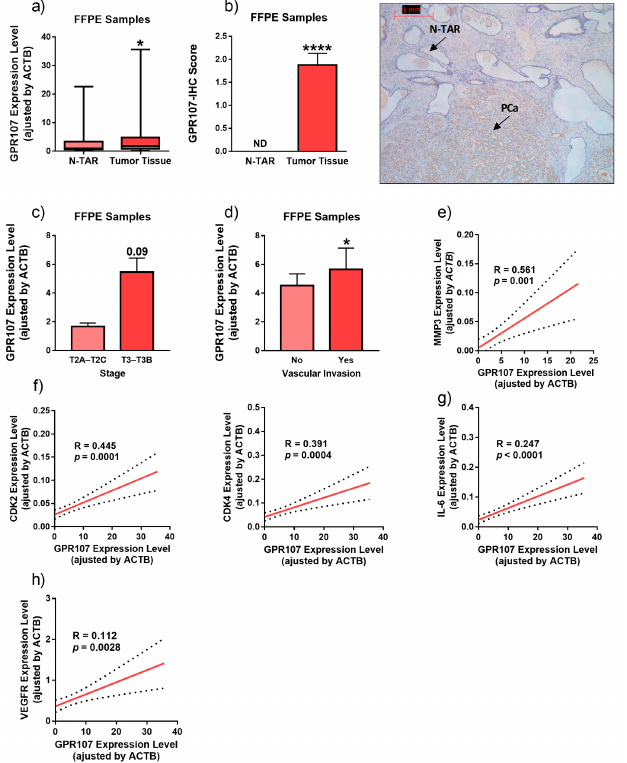
Figure 1. Expression levels of G protein-coupled receptor 107 (GPR107) in human prostate cancer samples. ( a ) Comparison of GPR107 expression levels between formalin-fixed paraffin embedded (FFPE) samples from Prostate Cancer (PCa) tissues and non-tumor adjacent regions (N-TAR) ( n = 84). ( b ) Comparation of GPR107 protein levels by Immunohistochemistry (IHC) between a representative set of PCa samples ( n = 16) and its N-TAR ( n = 16). A representative image is also included. ( c , d ) Association between GPR107 expression levels and advance stage of PCa ( c ) and vascular invasion ( d ). ( e–h ) Correlation of GPR107 expression levels and Matrix Metallopeptidase 3 (MMP3; ( e ), Cyclin Dependent Kinase 2 and 4 (CDK2 and CDK4, respectively; ( f ), Interleukin 6 Receptor (IL6-R; ( g ) and Vascular endothelial growth factor Receptor (VEGFR; ( h ) expression levels in the same cohort of FFPE samples. Messenger RNA (mRNA) levels were determined by quantitative Polymerase Chain Reaction (qPCR) and adjusted by Actin Beta (ACTB) expression levels. Asterisks (* p < 0.05; **** p < 0.0001) indicate statistically significant differences between groups. ND: Non-detected.